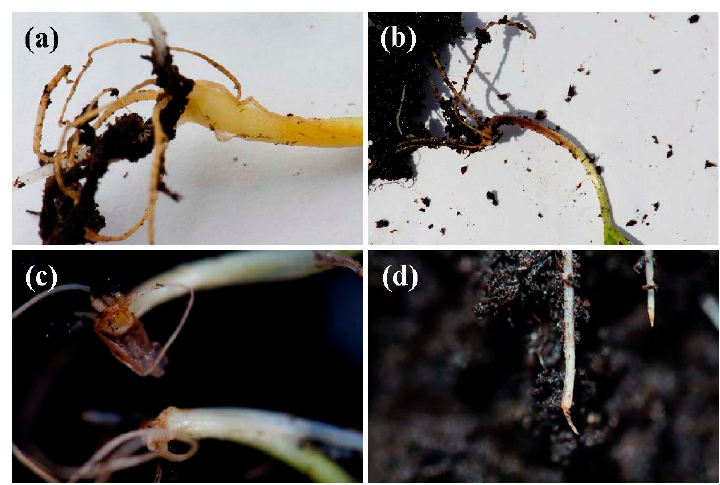
Figure 5. Different root rot symptoms observed in the artificially inoculated seedlings: ( a ) healthy coleoptile and roots; ( b ) necrotic lesions on the coleoptile; ( c ) necrotic lesions on the lower coleoptile, with scarce root development (top) vs. healthy seedling (bottom); ( d ) root apex browning.